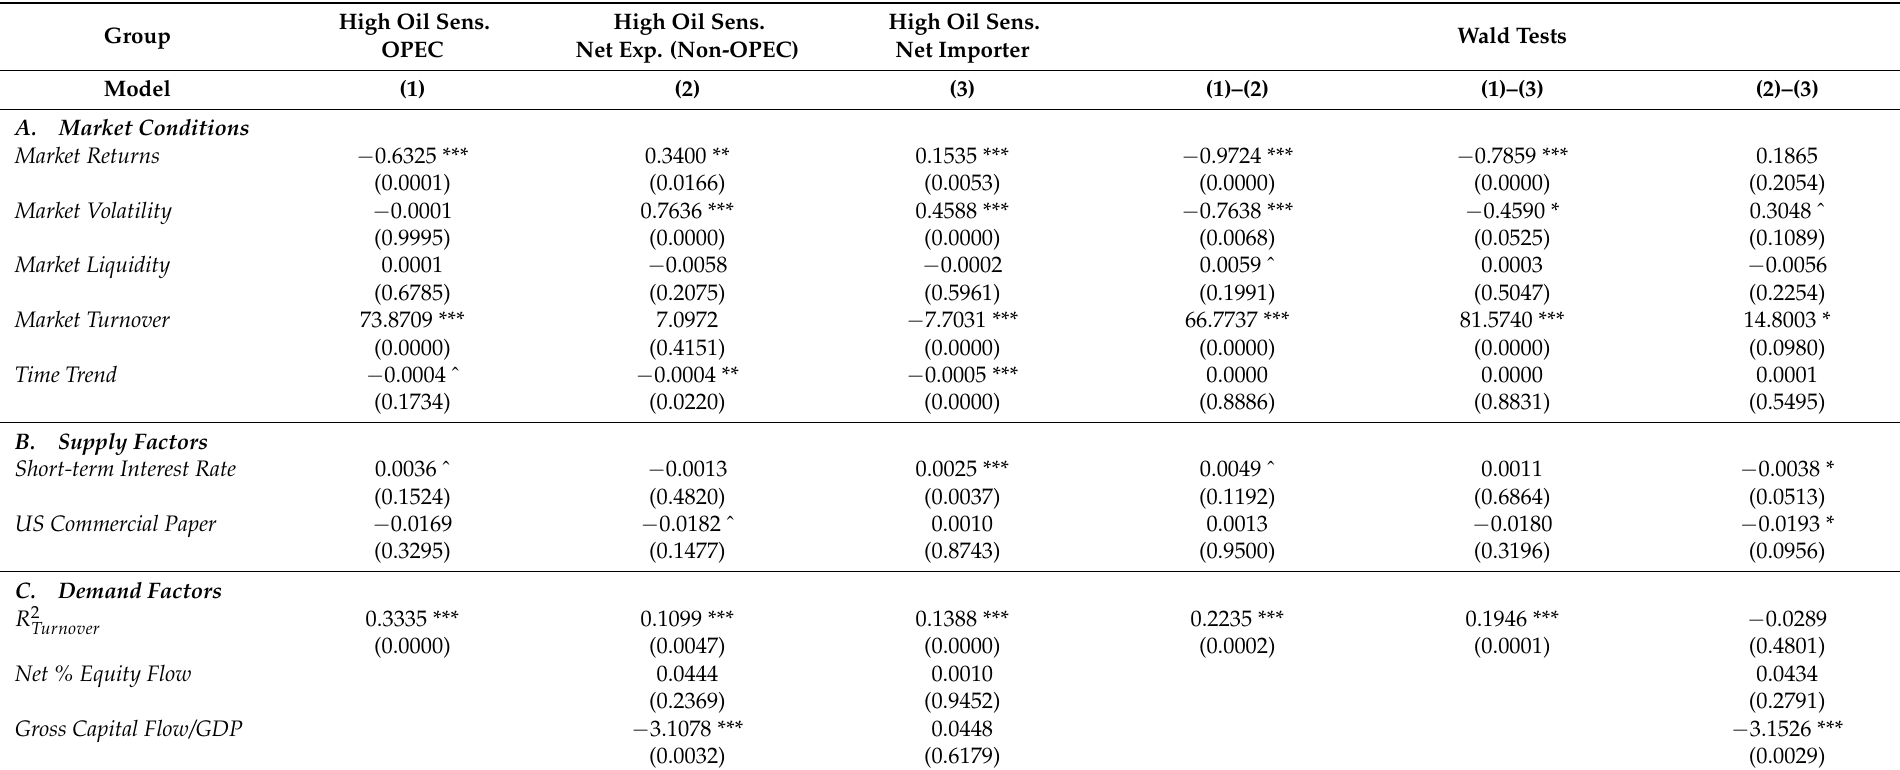
Table 7. Seemingly unrelated regressions of commonality in liquidity on sources of commonality: OPEC and non-OPEC net exporters and net importers. This table reports the results SUR of 50 equations, representing the number of countries in our sample. All equations are jointly estimated for the period from January 1995 to December 2015. In each model, we restrict the coefficients to be equal within each group but to vary across four groups. The first group includes highly oil-sensitive OPEC net exporters (countries whose oil sensitivity ratio is above the median of all countries and that are OPEC net exporters). The second group includes highly oil-sensitive non-OPEC net exporters (countries whose oil sensitivity ratio is